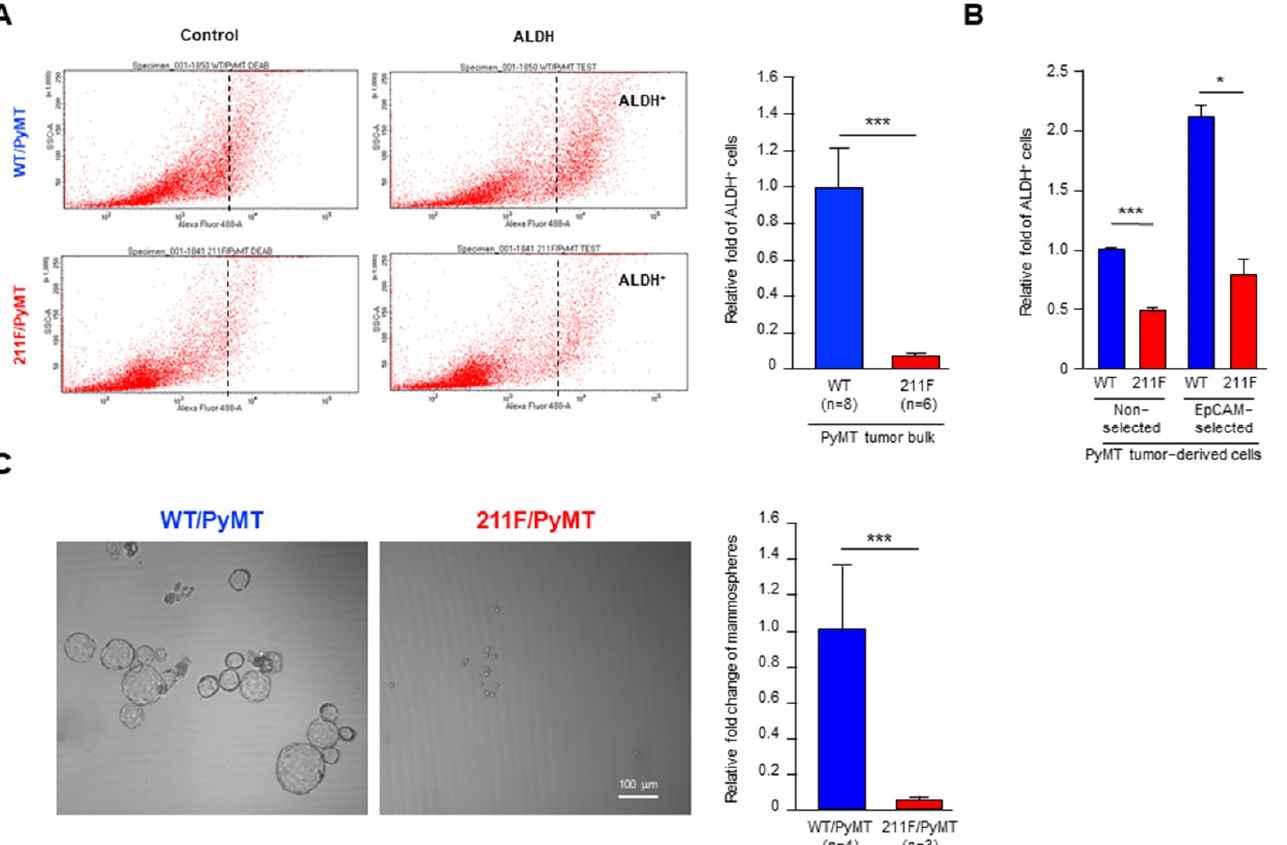
Figure 4. Y211 phosphorylation is important for maintaining the stemness of cancer cells in vivo. ( Left ), representative mammosphere formation is shown. ( Right ), tumor cells isolated from limiting dilution-derived tumor tissues were inoculated in suspension culture, and the formed